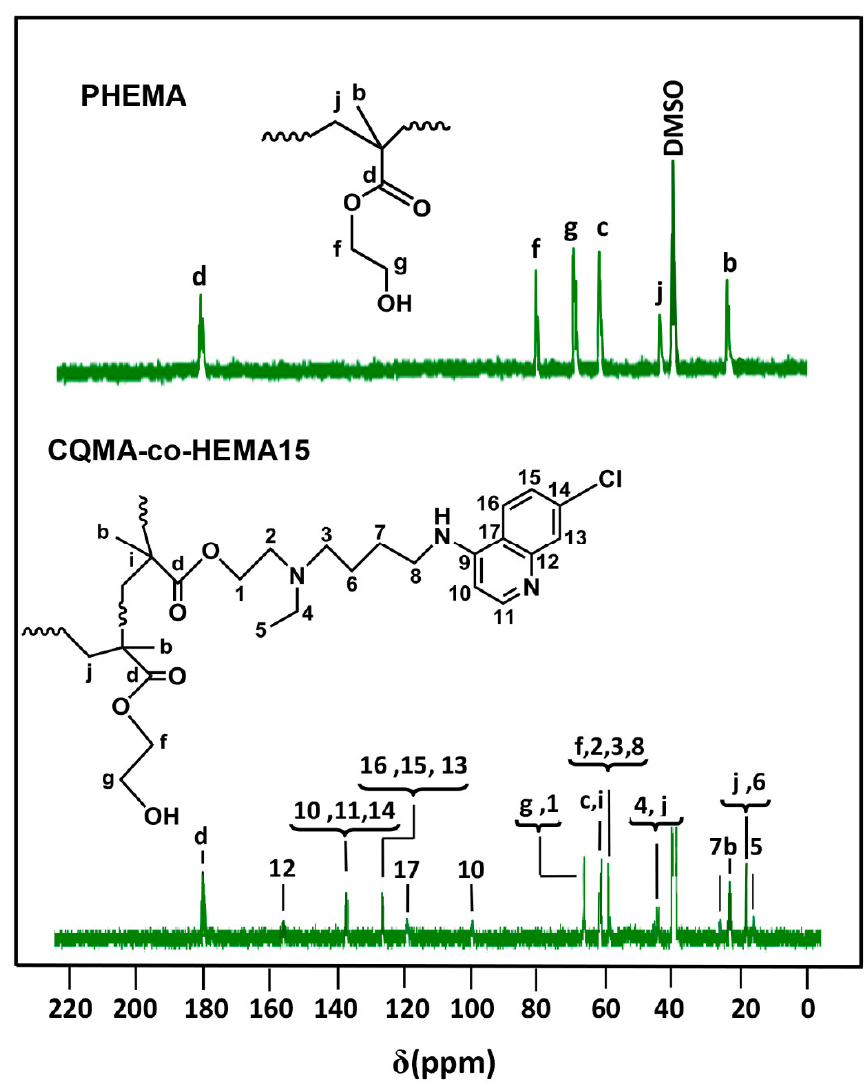
Figure 6. 13 C NMR spectra of PHEMA homopolymer and CQMA-co-HEMA15 copolymers.